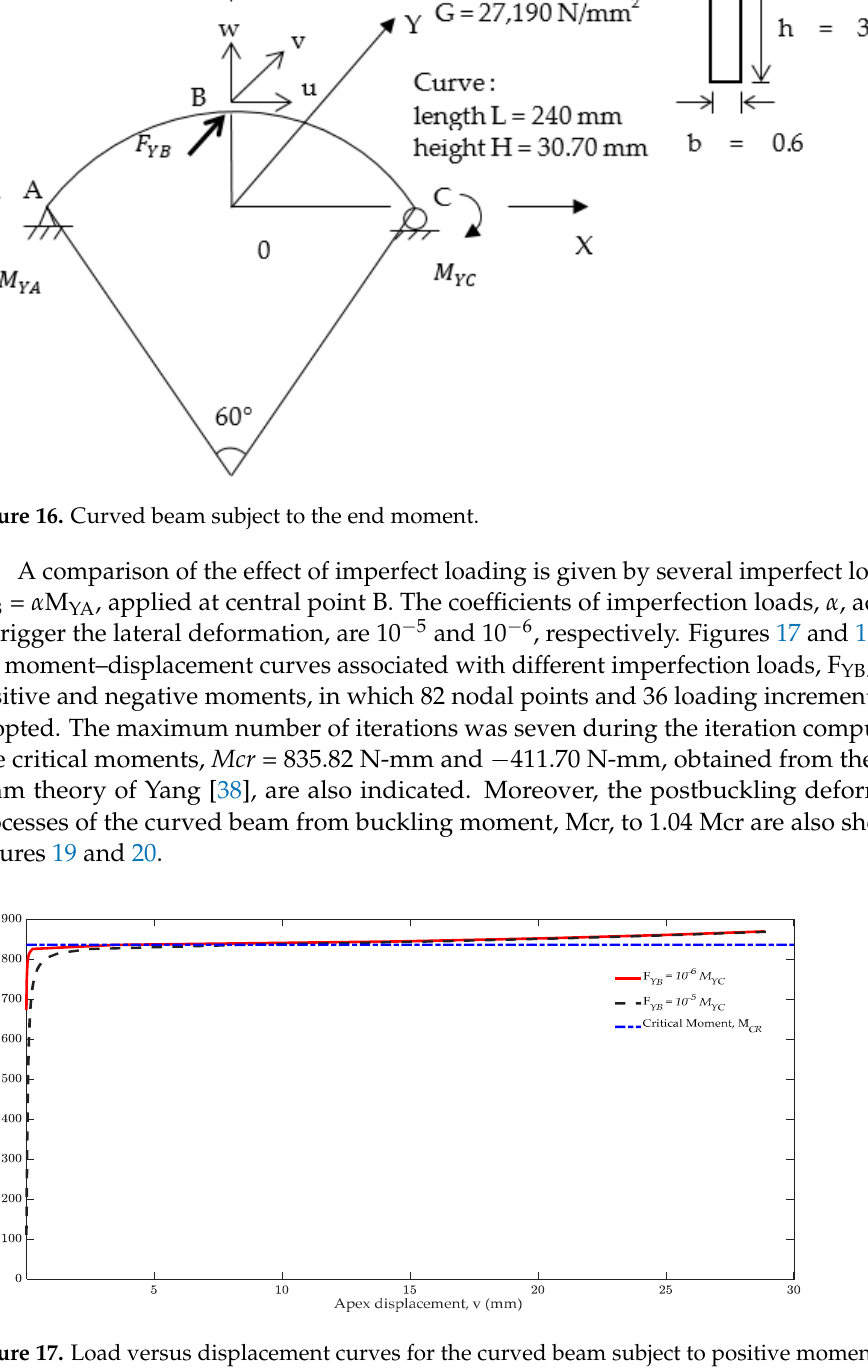
Figure 17. Load versus displacement curves for the curved beam subject to positive moment.